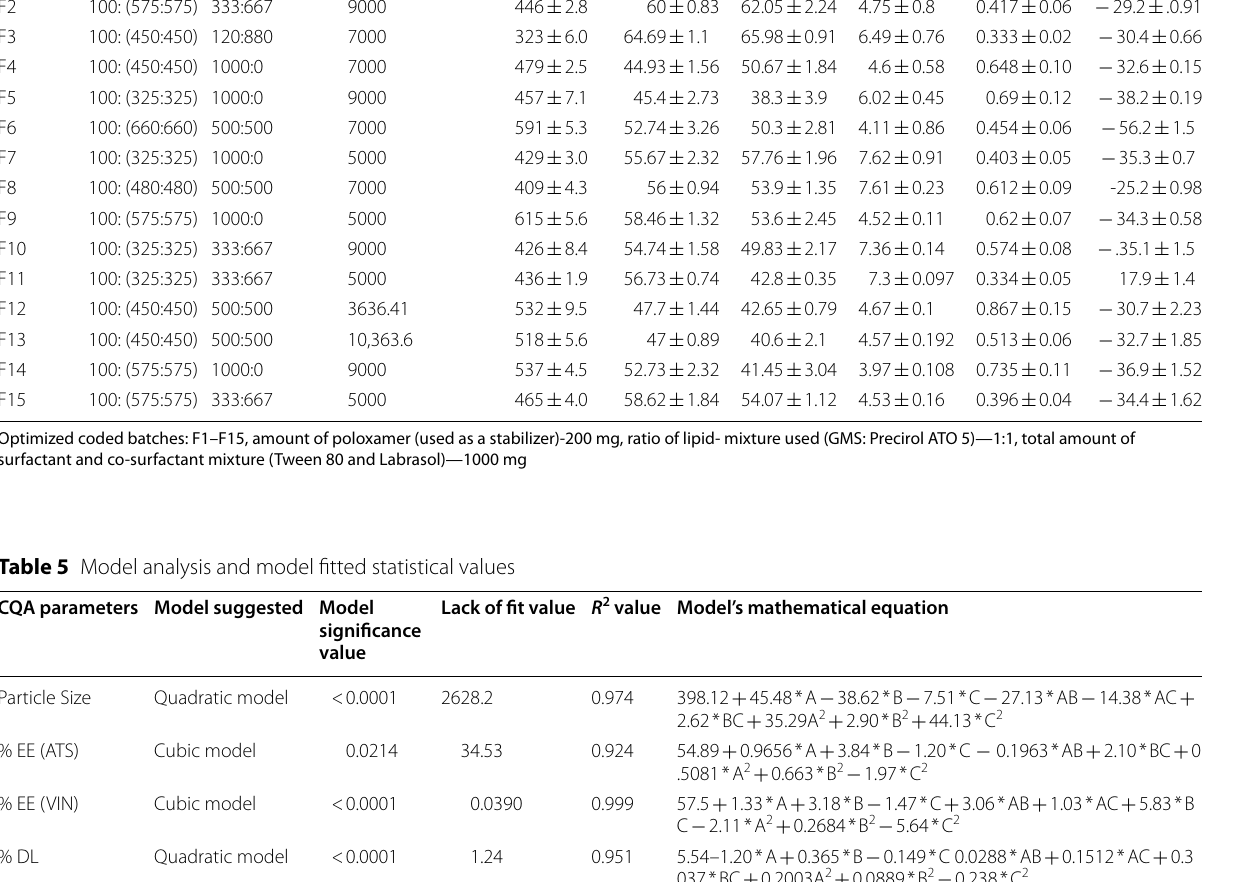
EE, entrapment efficiency; DL, drug loading; A, drug lipid ratio; B, surfactant co surfactant ratio; C, homogenization speed